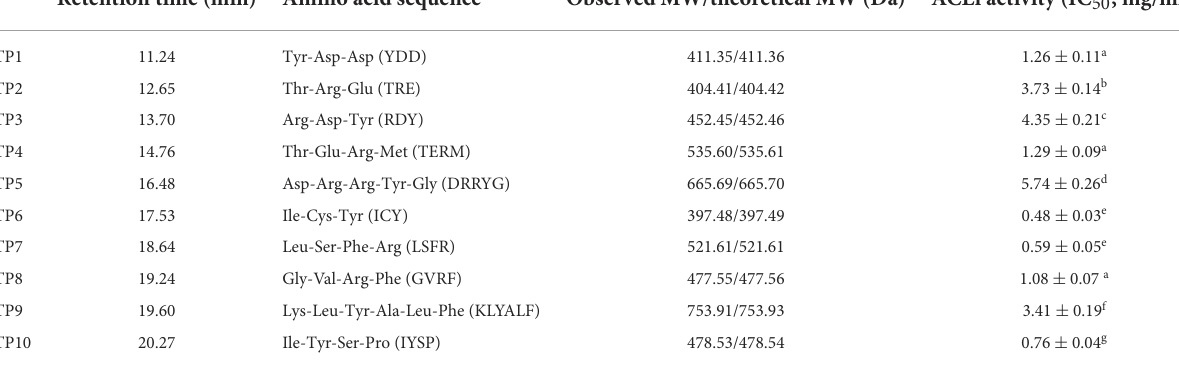
TABLE 1 Amino acid sequences, molecular weights (MWs), and ACEi activity (IC 50 value) of 10 isolated ACEi peptides (TP1–TP10) from protein hydrolysates of skipjack tuna milts (TMH). Retention time (min) Amino acid sequence Observed MW/theoretical MW